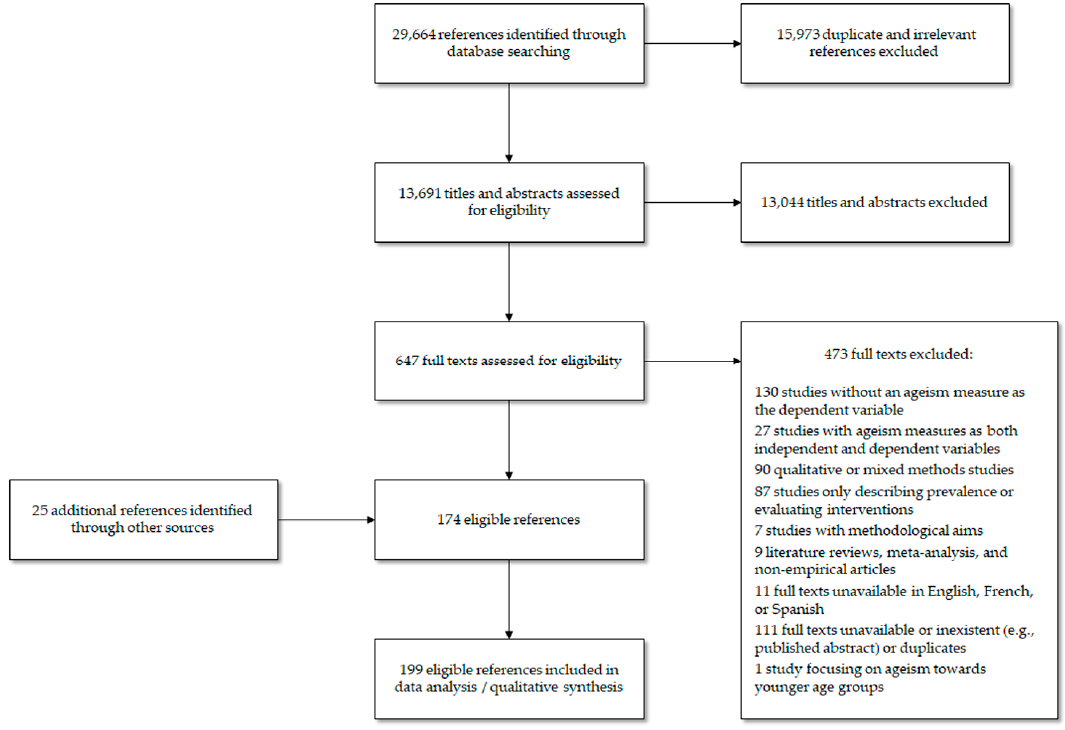
Figure 1. PRISMA flow diagram.